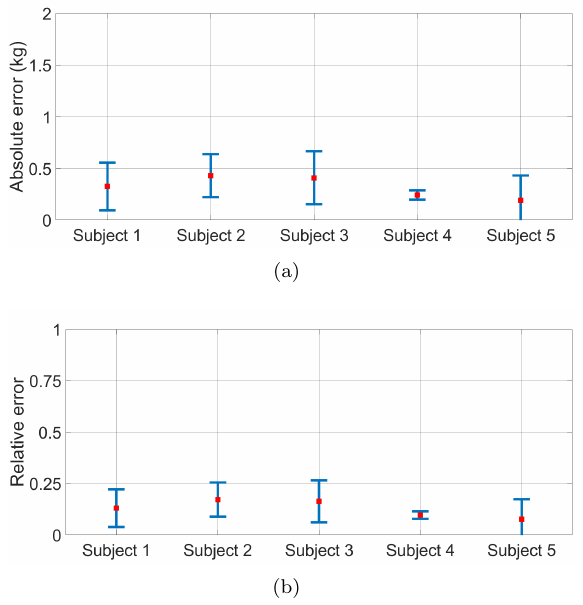
Figure 8: Errors of estimation, (a) absolute error, and (b) relative error, where red dot refers to the mean values.